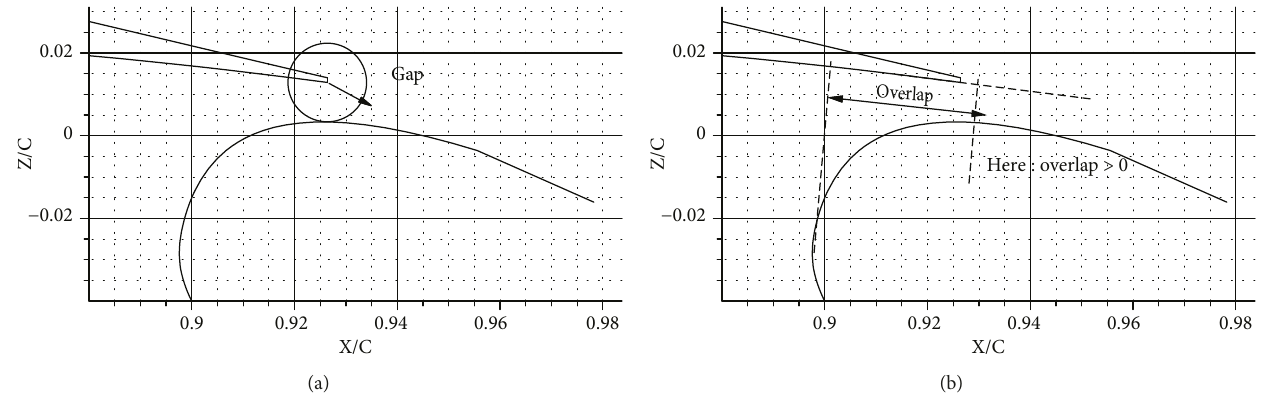
Figure 16: De fi nition of gap and overlap used for fl ap settings.